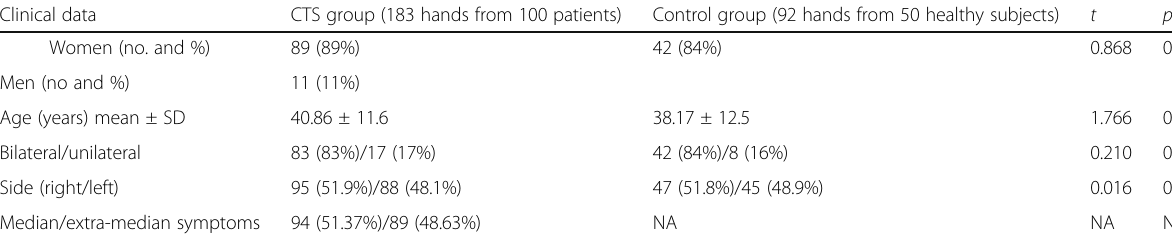
Table 1 Clinical characteristics of patient and control groups Clinical data CTS group (183 hands from 100 patients) Control group (92 hands from 50 healthy subjects) t p Women (no. and %)